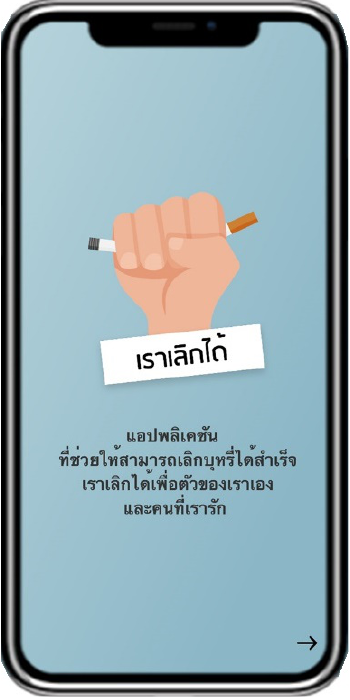
Figure 1. Logo of Quit with US.